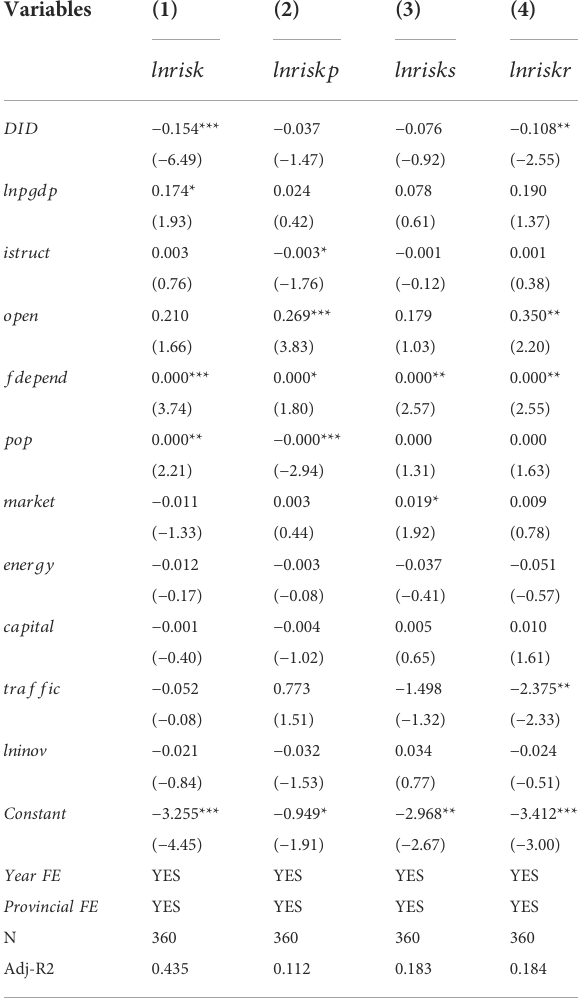
TABLE 3 Baseline regression